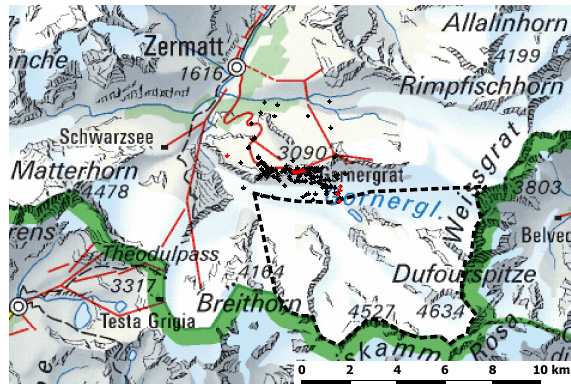
Figure 5: Zermatt area. The red dots represent the GPS images location, while black dots are the images with geotags only. The dashed line encloses the area of interest. Most of the images are shot from the Gornergrat